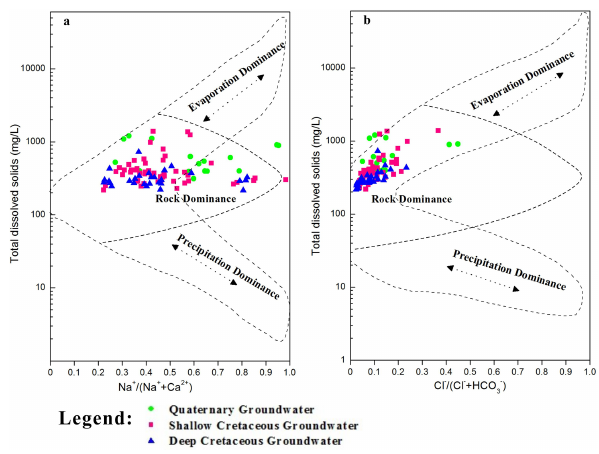
Figure 11. Gibbs diagram of groundwater samples in the Subei Lake basin: (a) TDS vs. Na + / (Na + + Ca 2 + ) , (b) TDS vs. ) Cl − / (Cl − + HCO − 3